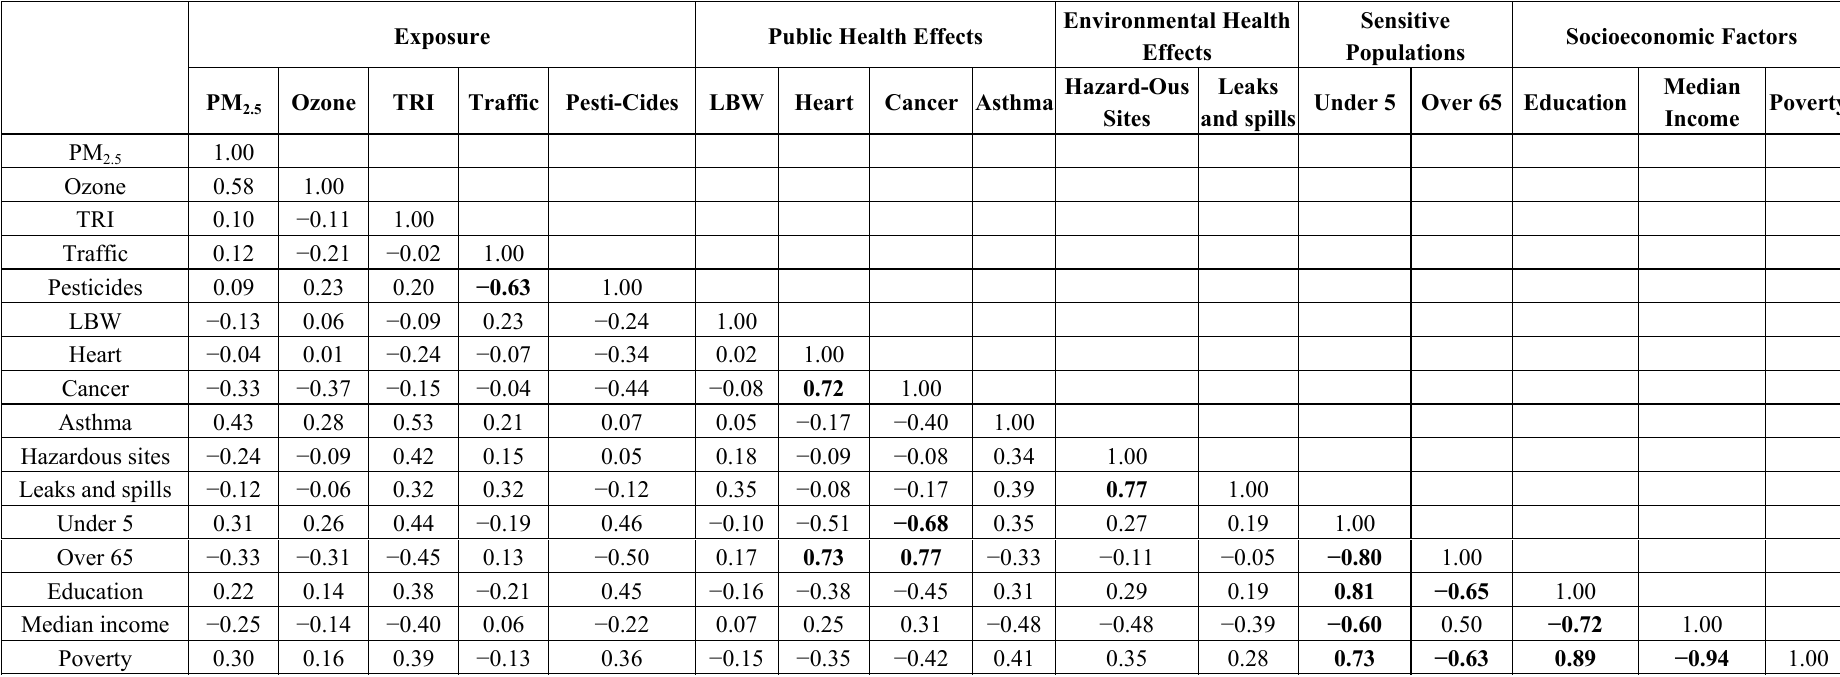
Table 3. Pearson’s correlation coefficients between indicators (n = 30). Absolute values ≥ 0.6 are highlighted in bold. Exposure Public Health Effects